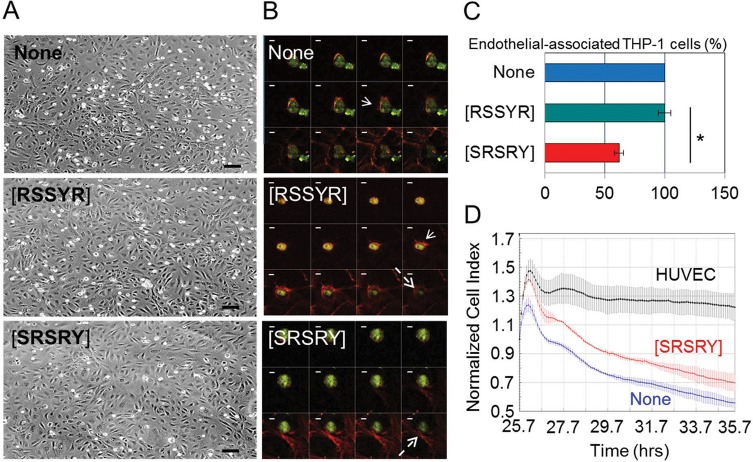
[SRSRY] prevents trans-endothelial migration of THP-1 cells.A-C. Effects of [SRSRY] on the morphology and number of THP-1 adhered to endothelial monolayer. HUVECs (5x104/well) were seeded on matrigel coated coverslips and allowed to adhere for 3 hours, prior to adding GFP-tagged THP-1 cells (1x104 cells/well) exposed to diluents, or the indicated peptides at 10 nM concentration in complete endothelial medium for 30 minutes at 37°C. Representative images of co-cultures analyzed by phase contrast microscopy at 100x with Scale bar: 50 μm (A) or stained with rhodamine- phalloidin and recorded by a confocal microscope (z-series with 0.25 μm intervals) at 630x with Scale bar: 10 μm (B). Arrows: F-actin rich lamellipodia; dotted arrows: THP-1 cells underneath the endothelium. C. Fluorescent THP-1 cells which were adherent on the endothelial monolayer were counted on 10 fields/slide at 200x magnification. Data are expressed as the percentage of the endothelial-associated GFP-THP-1 cells in the absence of peptides (None = 100%).*Statistical significance with p<0.001. D. HUVECs (1x104 cells/well) were seeded in E-plates and allowed to o adhere for ~24 hours until they form a confluent monolayer, prior to seeding THP-1 cells (1x104 cells/well) in the presence of 10% FBS plus/minus 10 nM [SRSRY]. Endothelial invasion by THP-1 cells was monitored in real-time for 10 hours as changes in Cell Index. Values were normalized immediately after THP-1 cell addition. Data represent mean ± SD from a quadruplicate experiment.